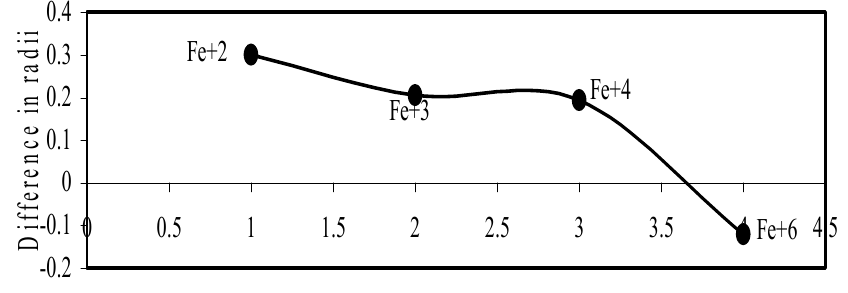
Figure 18. Plot if difference in experimental and theoretical radii of Fe in different oxidation states.